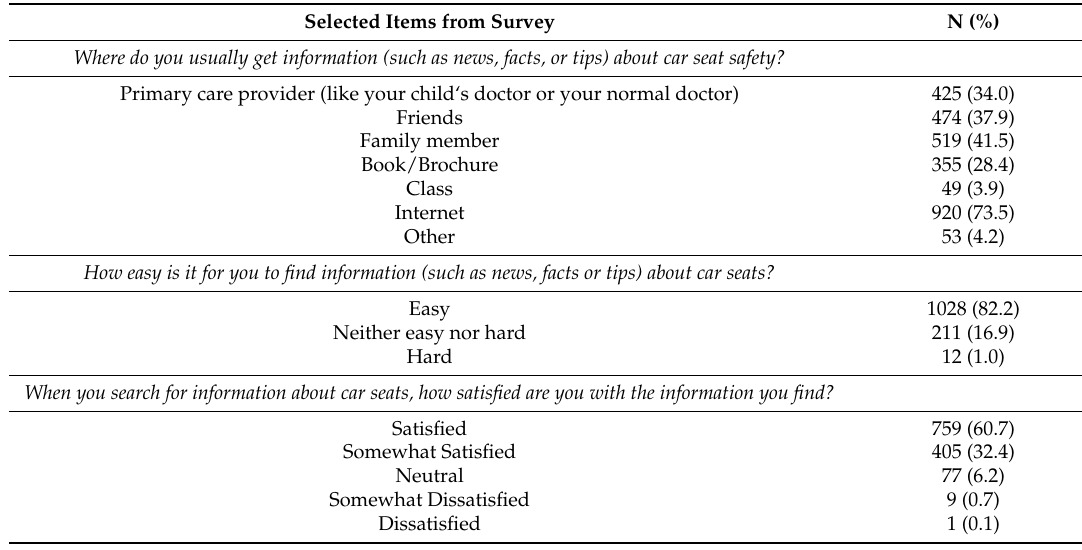
Table A3. Parents’ car seat installation